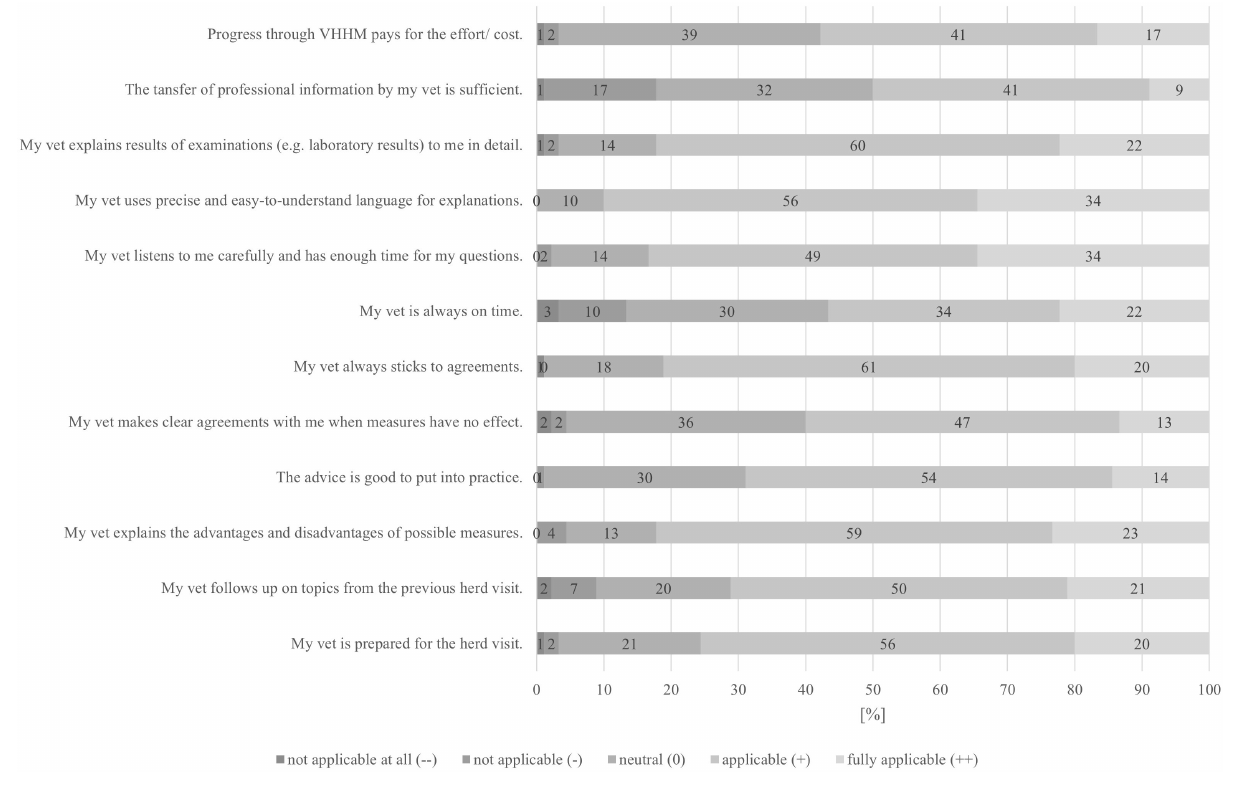
FIGURE 3 | Bar chart: Cooperation between farmer and